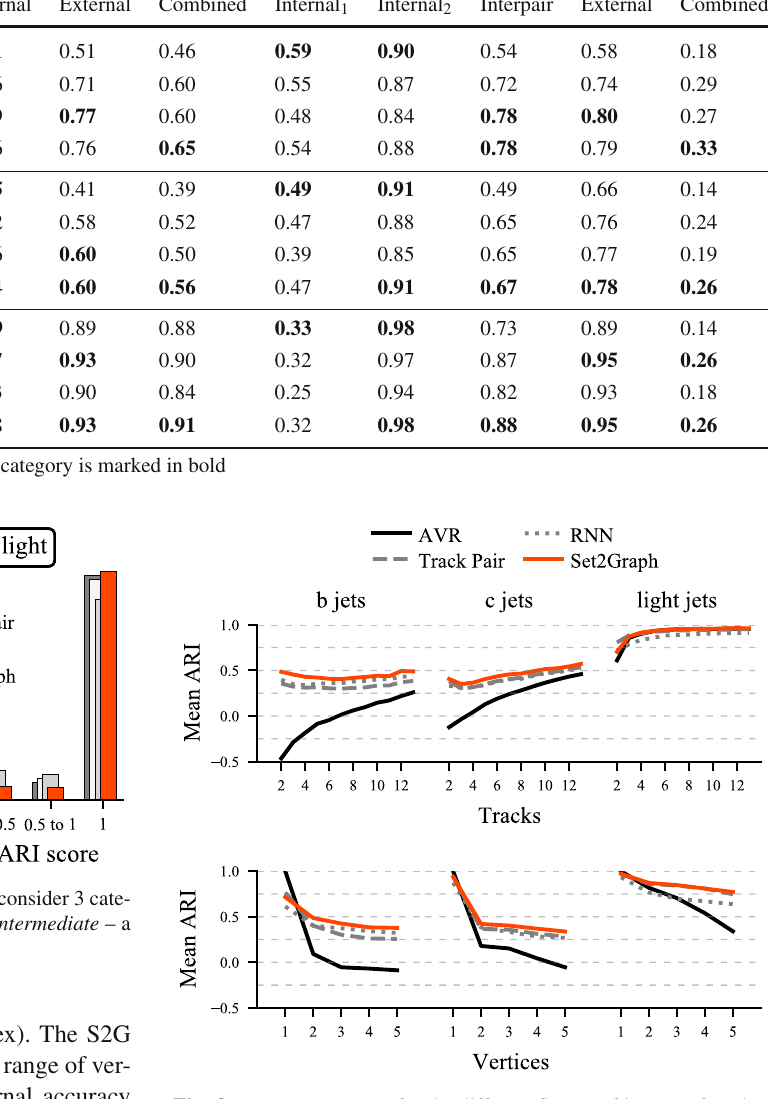
Fig. 9 Mean ARI scores for the different flavors of jets as a function of the jet